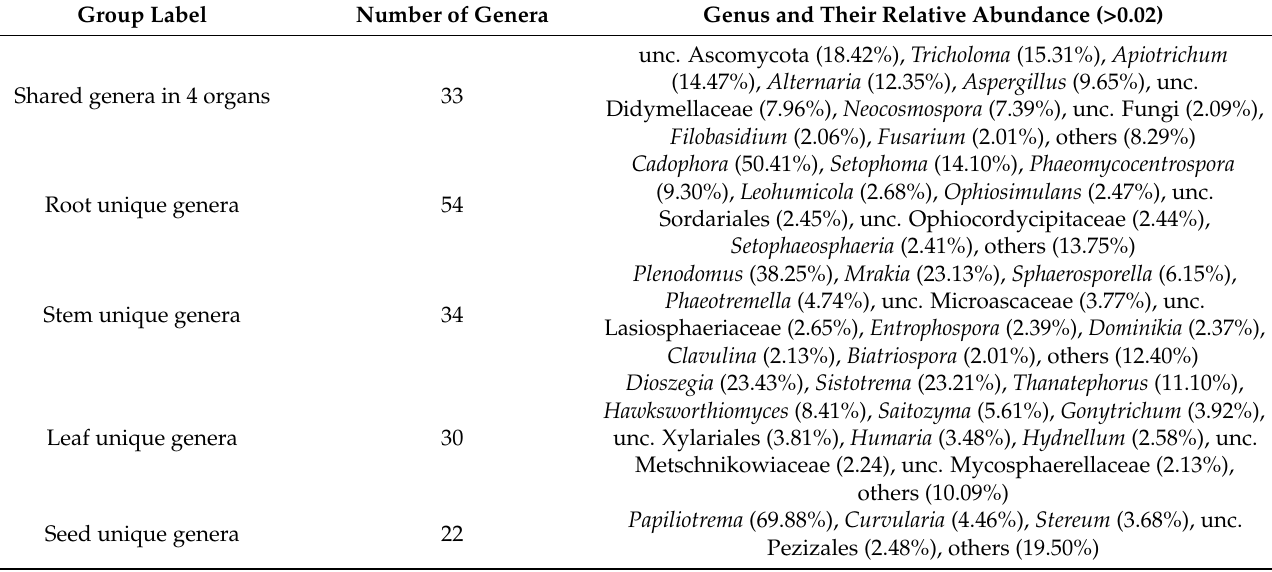
Table 4. Common and unique genera of endophytic fungal fungi from different organs of S. alopecuroides